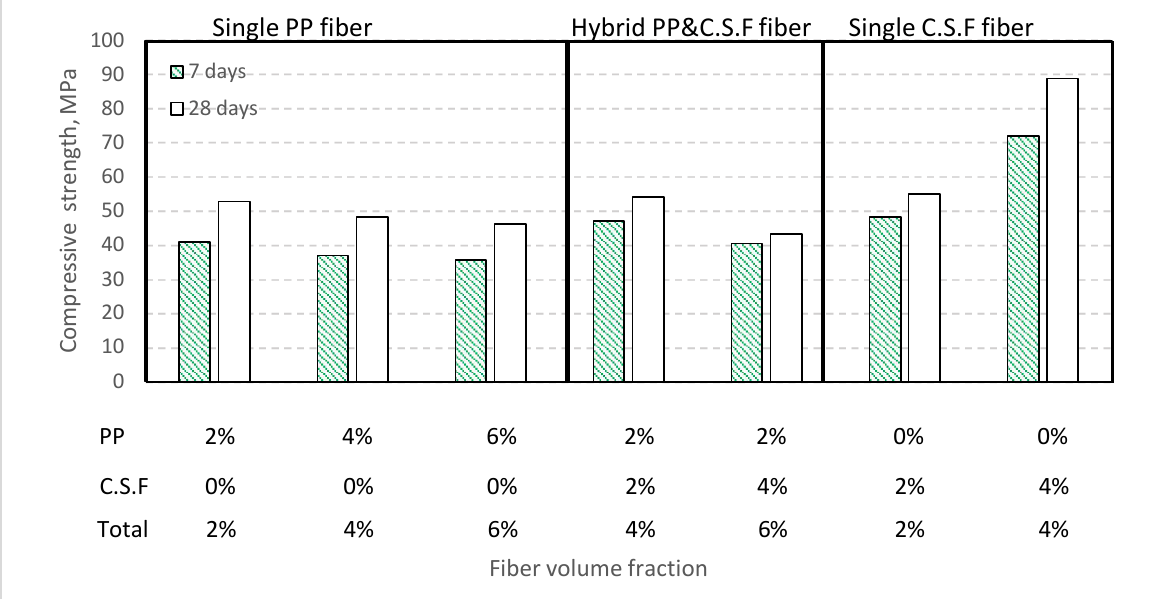
Figure 14. Effect of lightweight and heavyweight fiber hybridization on 7 and 28-day concrete com- pressive strength.